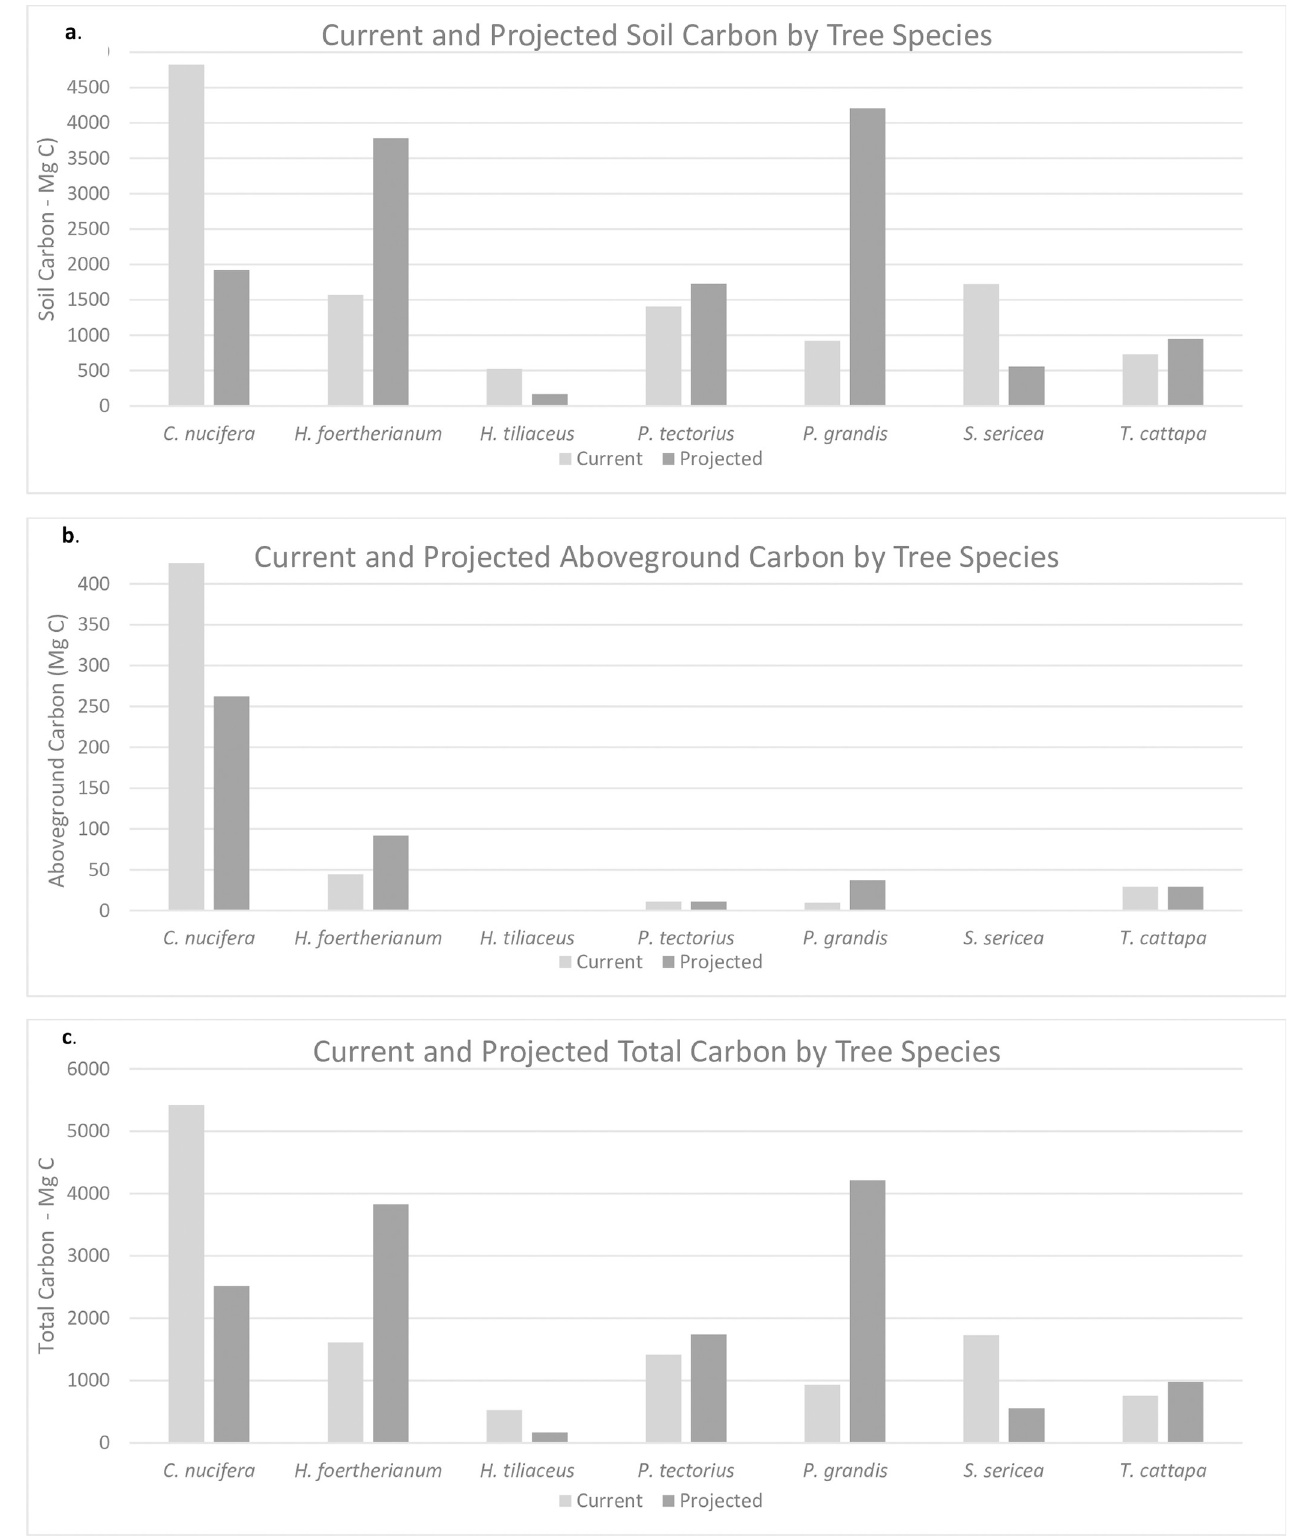
Fig 2. Current and future projections of soil organic carbon, (2a), aboveground carbon (2b), and total carbon (soil and aboveground) (2c) by tree species.